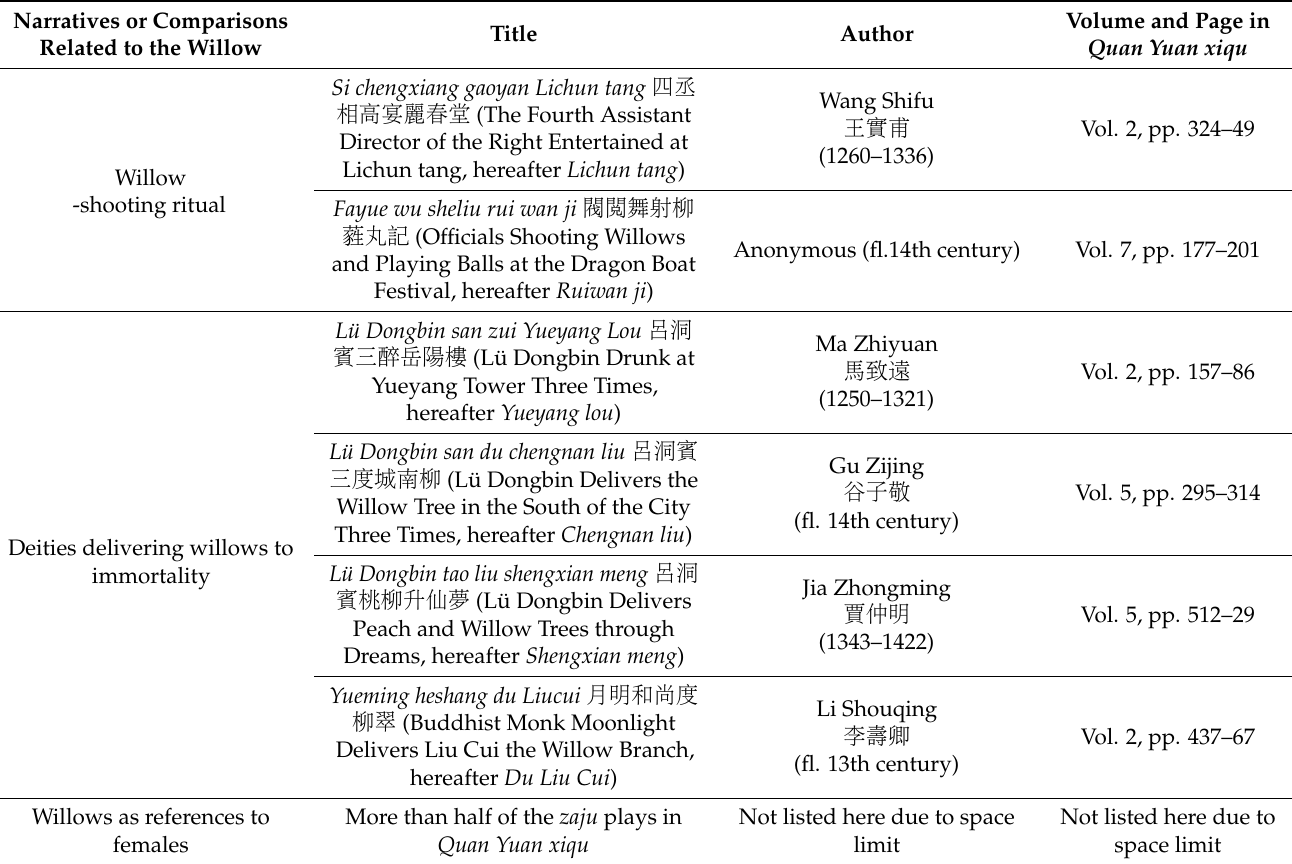
Table 1. Three types of narratives of the willow in Yuan Zaju